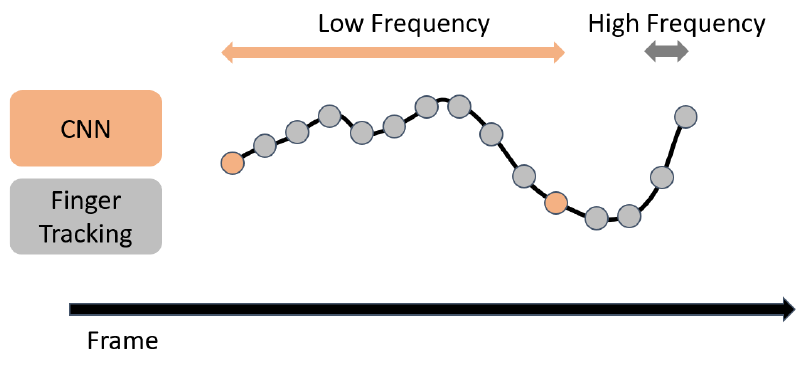
Figure 4. Concept of fusing the CNN and finger